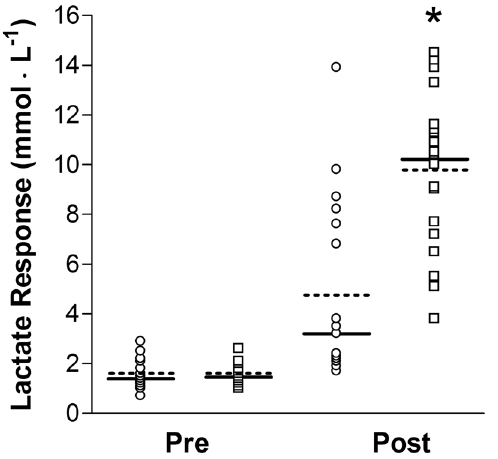
Figure 2. Mean (- - -) and median (—) blood lactate responses from pre- to post-exercise in strength ( ○ ) and hypertrophy ( □ ) conditions. * Post-exercise blood lactate levels greater in the hypertrophy than the strength condition ( p < 0.01).